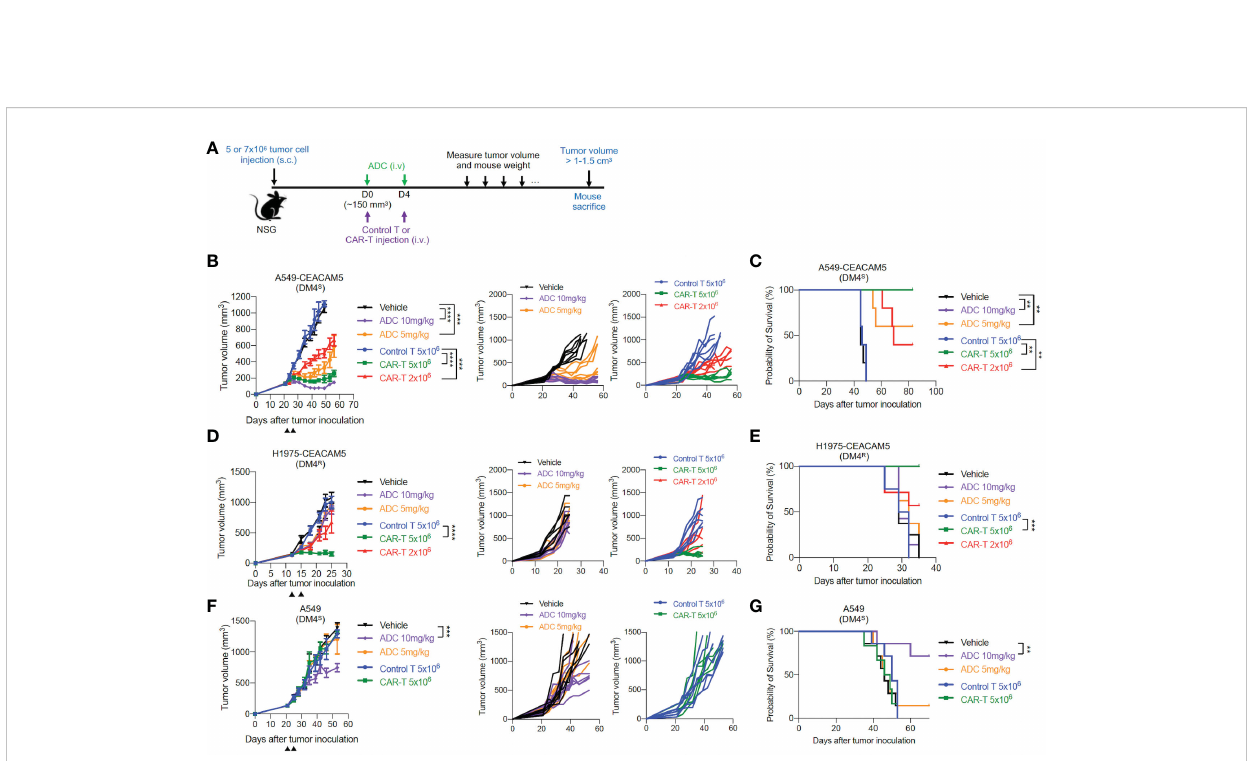
FIGURE 4 in vivo anti-tumor activities of the ADC SAR408701 analog and CAR-T cells targeting CEACAM5 in DM4 S and DM4 R NSCLC tumors. (A) Schematic representation of experimental design and treatment schedule for mice studies. (B, D, F) Tumor growth curve (left panels) and individual mice curves (right panels) of DM4 S A549-CEACAM5 (B) , DM4 R H1975-CEACAM5 (D) , and CEACAM5-negative DM4 S A549 (F) tumors. Signi fi cance was analyzed by comparing the tumor volume (mm 3 ) ±SD at endpoint of 1.0 cm 3 (B) or end day ( D, F ) and determined using one-way ANOVA, followed by the tukey ’ s multiple post hoc test. ****, P <0.0001; ***, P <0.001. (C, E, G) Survival curve showing the ef fi cacy of the ADC SAR408701 analog and CAR-T cells in NSG mice. Tumor volume (mm 3 ) are shown as mean ±SD for n=6 or 7 per group. Survival was presented by Kaplan-Meier plot of percentage of mice with tumor volume ≥ 1-1.5 cm 3 . Signi fi cance was determined by log-rank (Mantel-Cox) test. ***, P <0.001; **, P